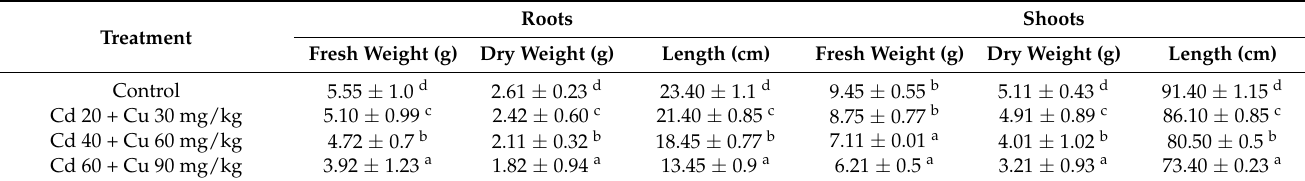
Table 1. The combine effects of cadmium (Cd) and copper (Cu) on the roots’ and shoots’ fresh and dry weights (g) and root and shoot length (L) in the pigeon pea plants. Various statistical letters represent significant differences from control. Roots Shoots Treatment